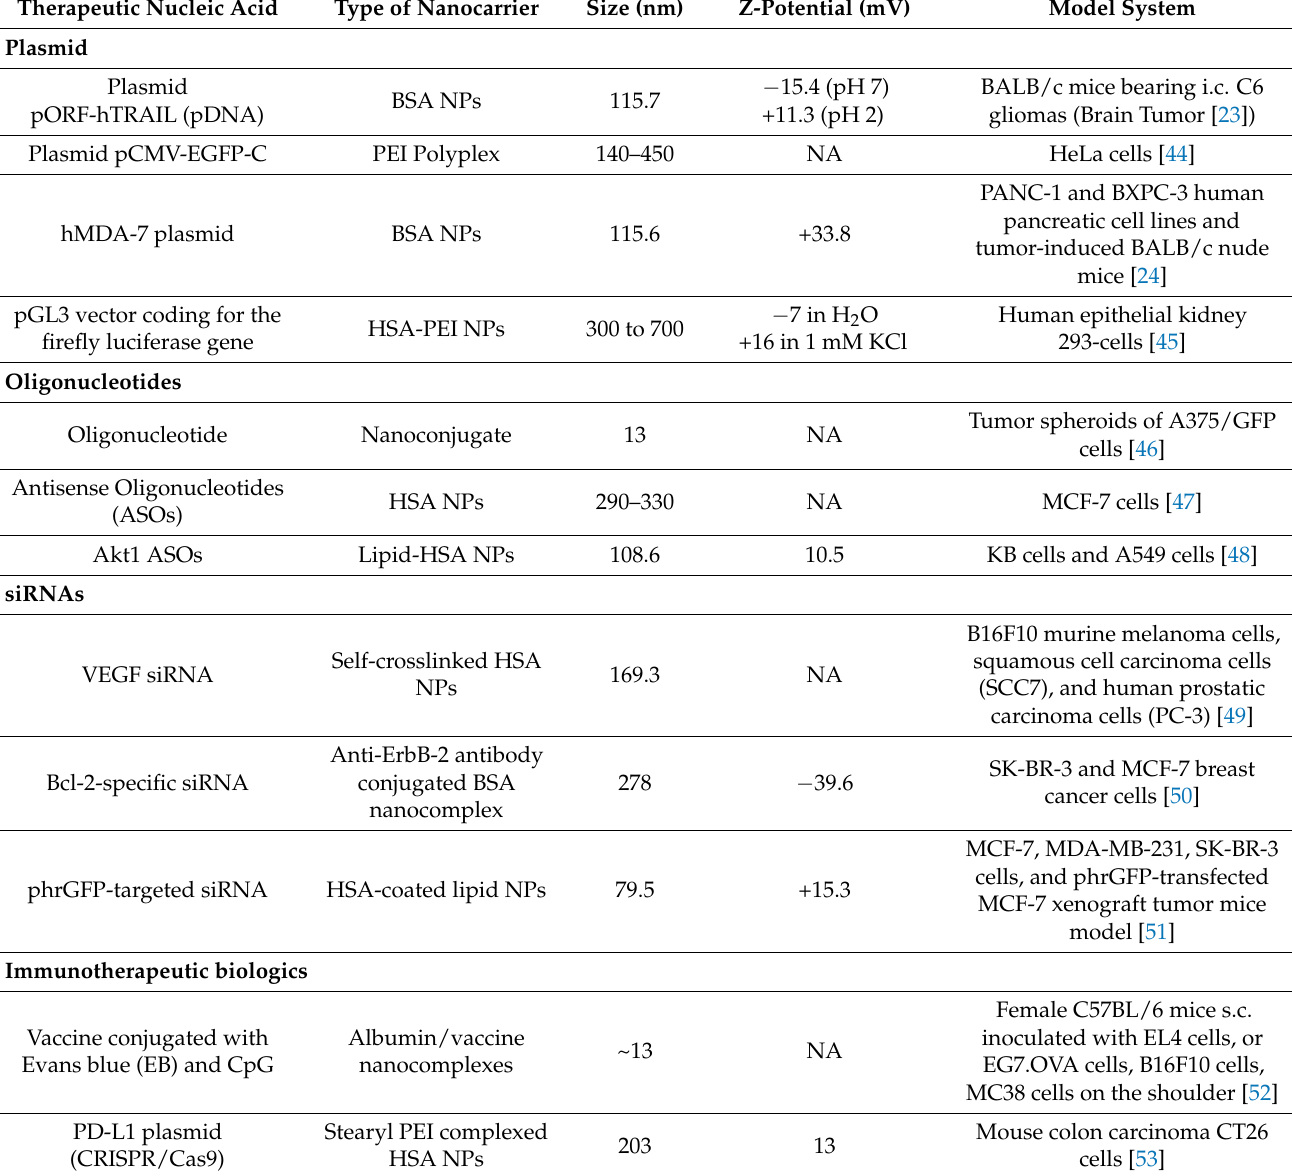
Table 1. List of albumin-based nanocarriers with nucleic acids for cancer